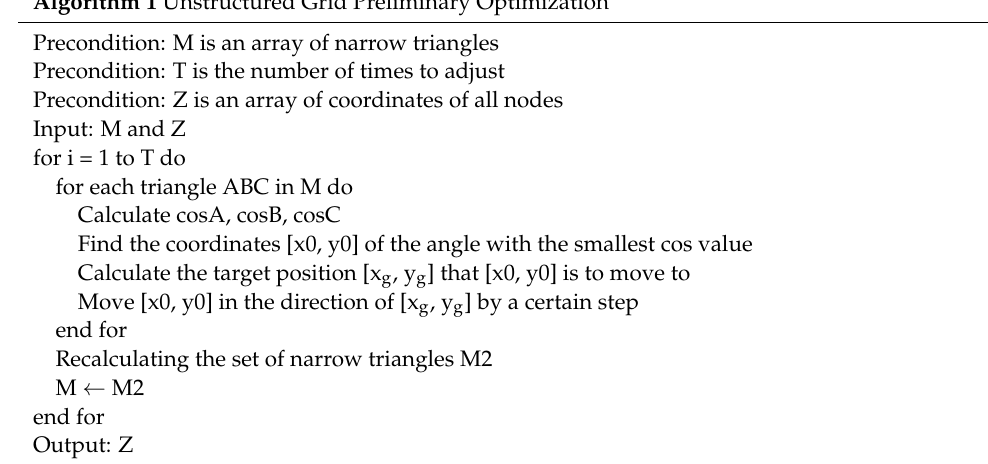
Algorithm 1 Unstructured Grid Preliminary